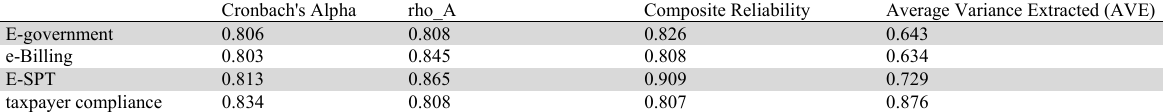
Construct Reliability and